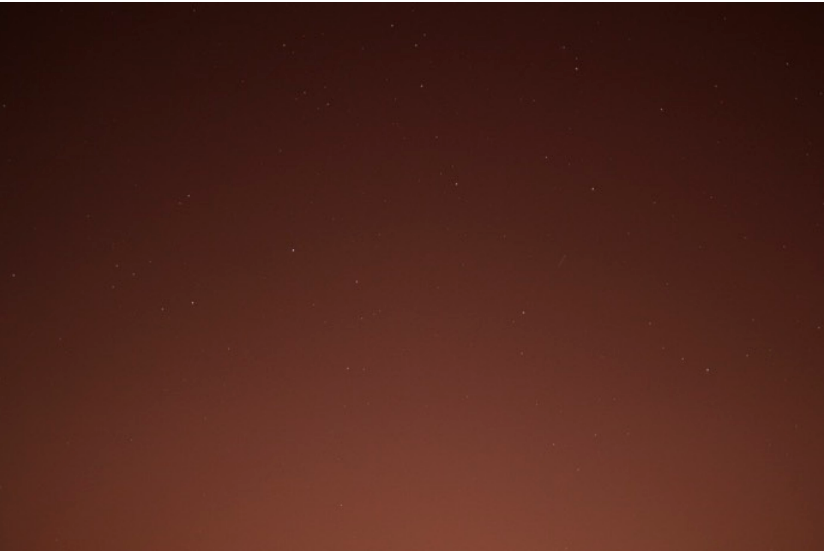
Figure 20. A frame from a sequence captured in Cluj-Napoca, at sunset, facing south-west. An LEO streak is highlighted by the red circle.